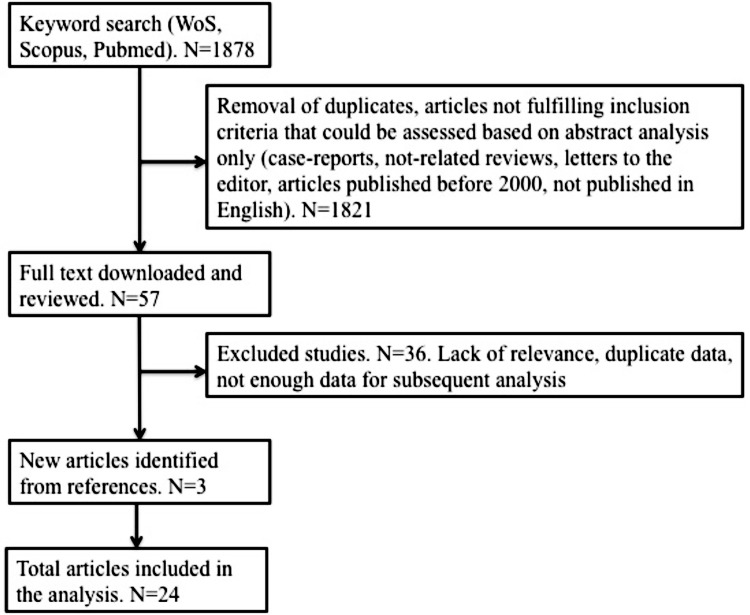
Search synthesis.